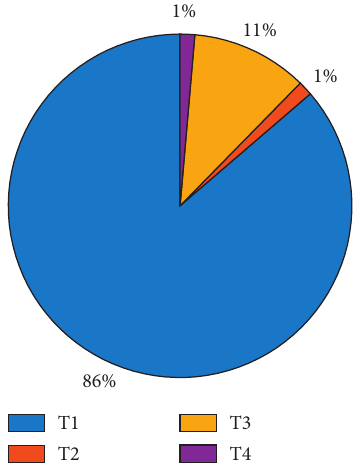
Figure 9: Percentage of precast RC buildings with different typologies.